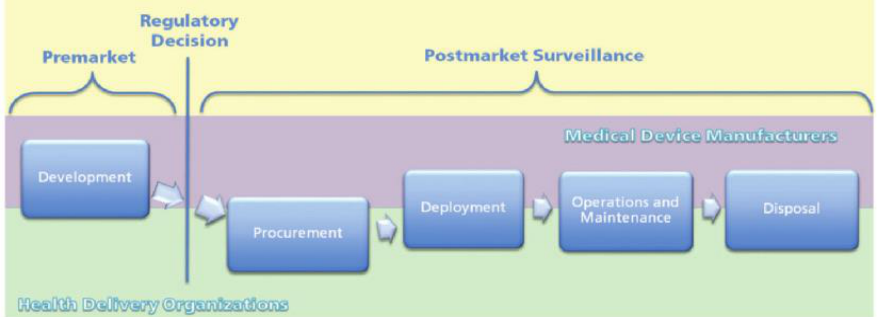
Figure 12. Medical device product life cycle [84].